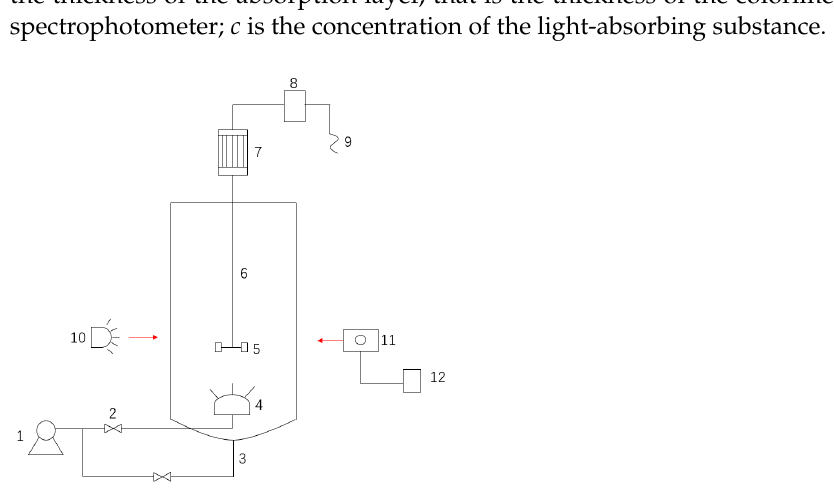
Figure 3. Schematic diagram of experimental device. 1 turbulence pump; 2 air pipe; 3 drain valve; 4 gas distributor; 5 stirring blade; 6 shaft; 7 electromotor; 8 frequency changer; 9 power supply; 10 light source;11 digital camera; 12 computer.